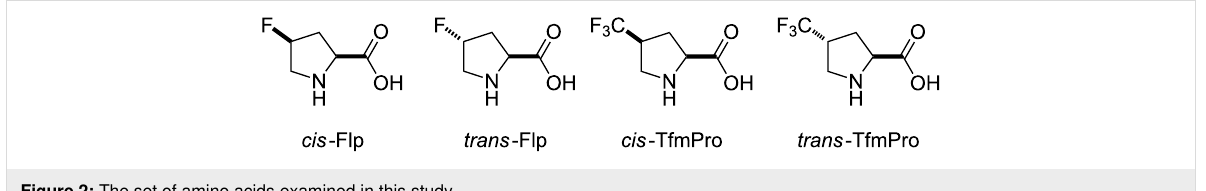
Figure 2: The set of amino acids examined in this study.